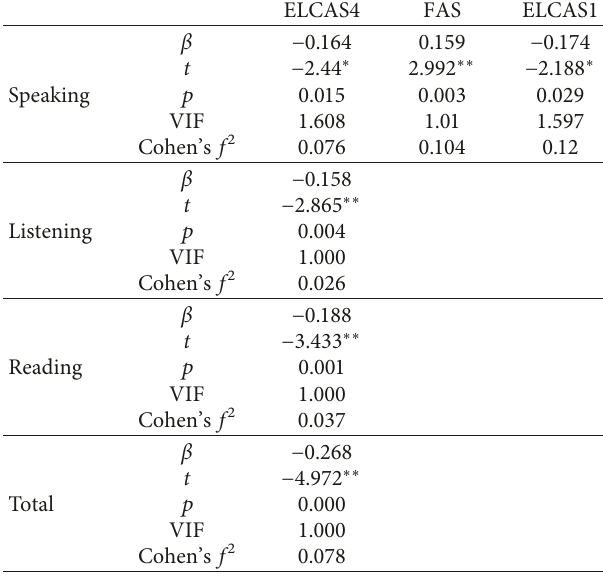
Table 9: Multiple regression coefficients and significance of Pre- dictors for Performance in English (phase